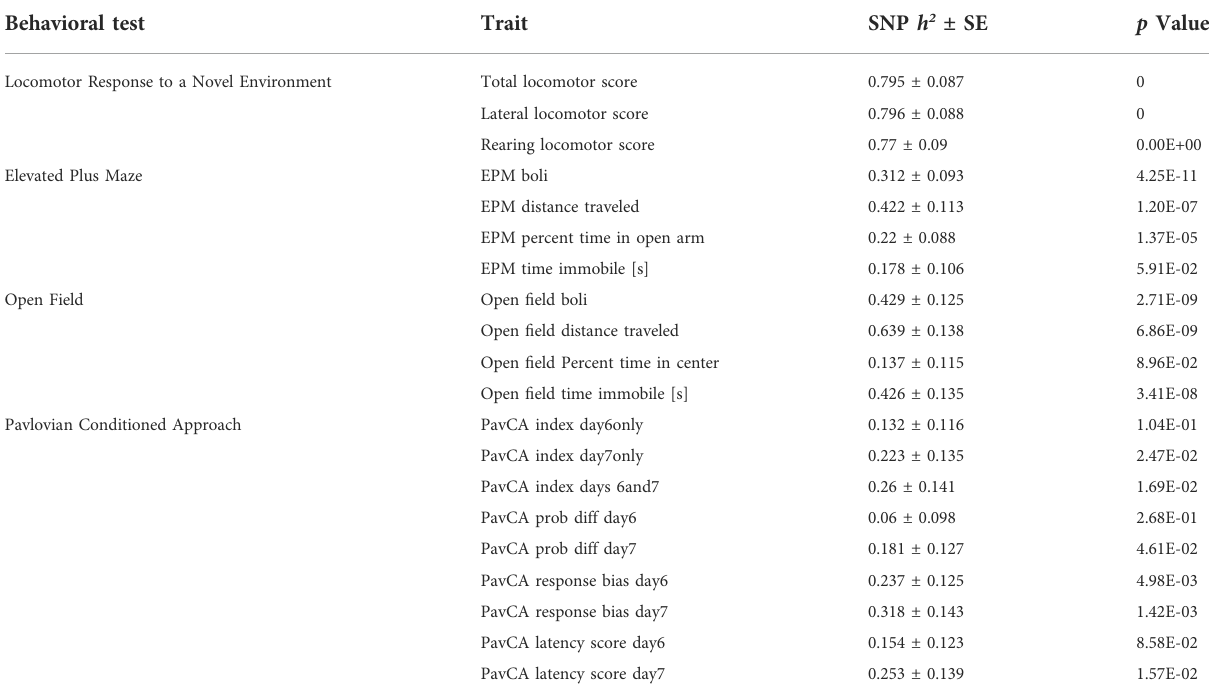
TABLE 2 SNP heritability estimates.